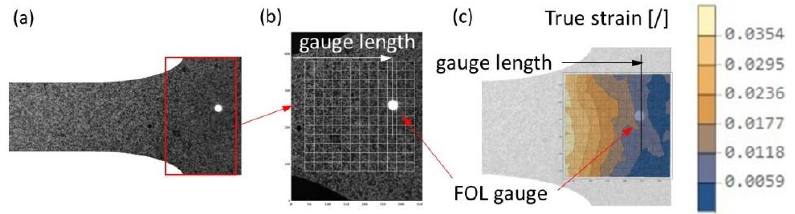
Figure 18. Strain field measurement using DIC: ( a ) specimen view, ( b ) design grid, ( c ) true strain distribution for the stretched area.